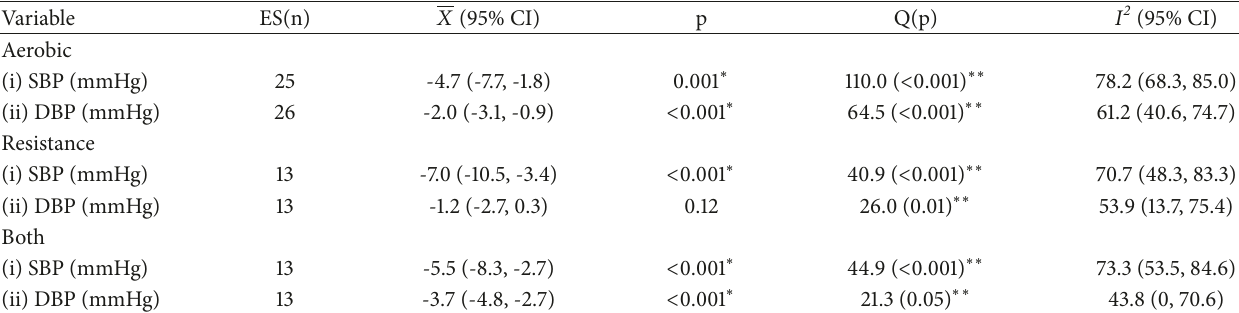
Table 1: Summary of change outcome differences for resting systolic and diastolic blood pressure using the IVhet model.